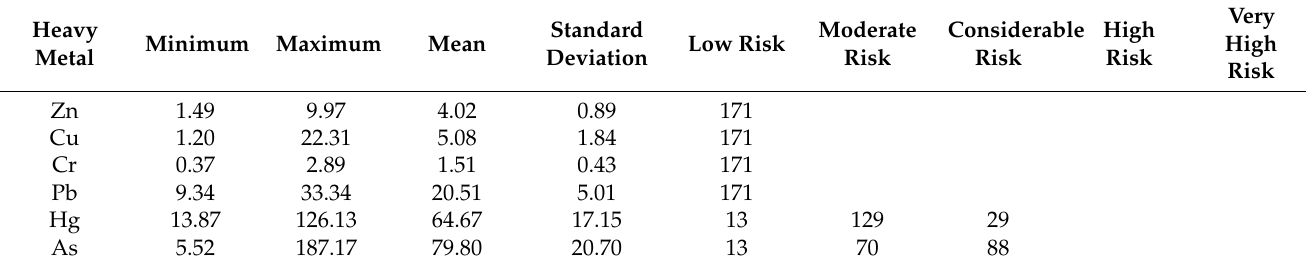
Table 4. Distribution frequency of the potential (E i r ) of each heavy metal in soil.